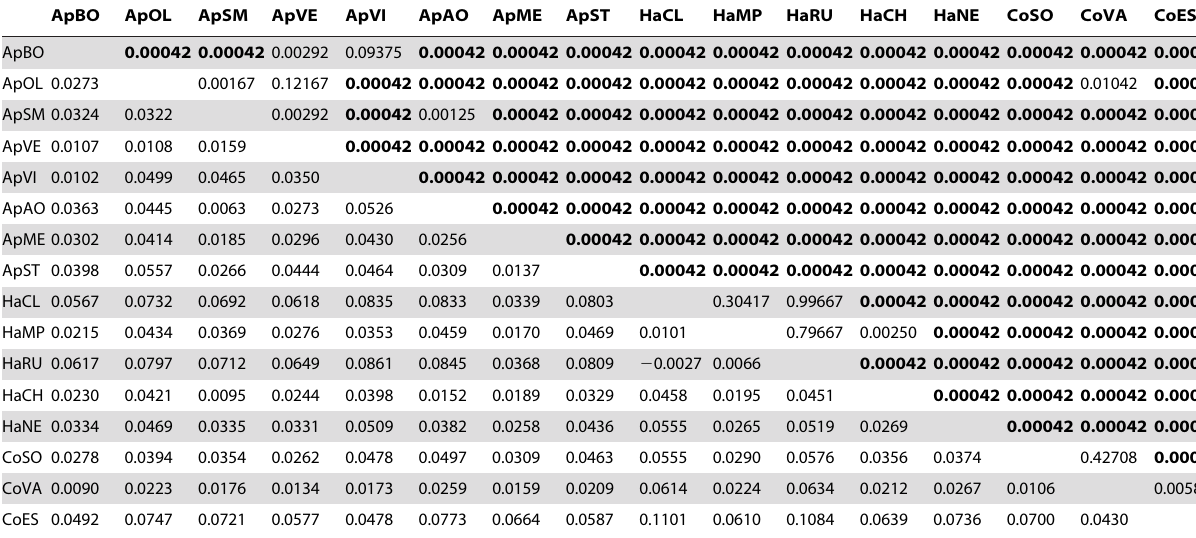
Table 4. Genetic differentiation between Cacopsylla melanoneura